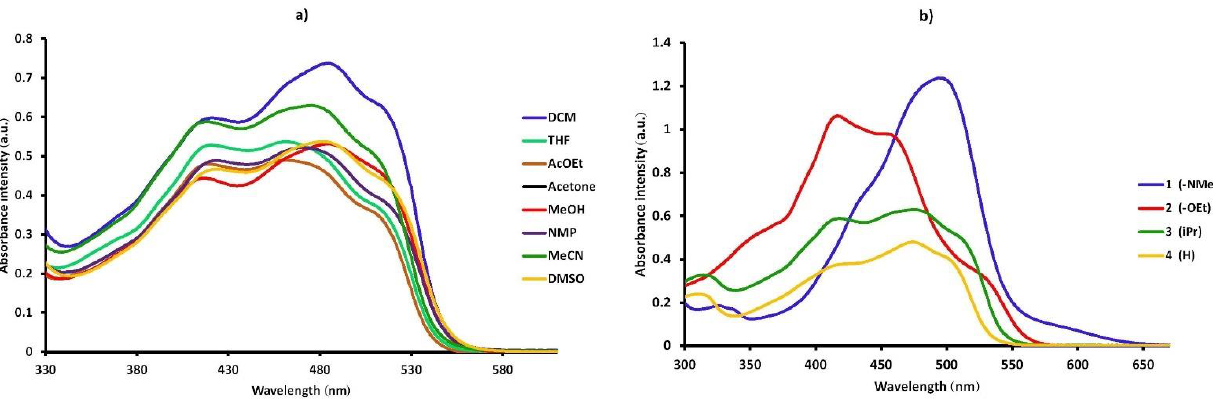
Figure 2. Absorption intensity spectra of 1-(4-isopropylo)phenylazonaphthalen-2-ol ( 3 ) in solvents of different polarity. ( a ) and absorption intensity spectra of 1 – 4 in acetonitrile ( b ) (5 × 10 − 5 M).